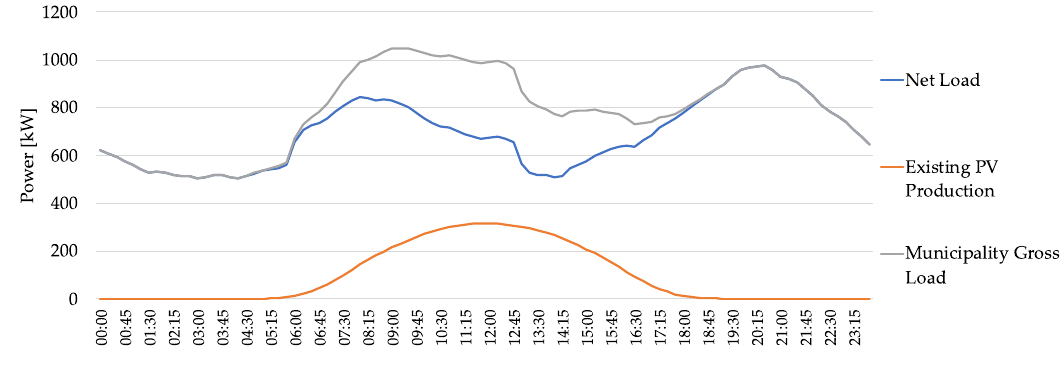
Figure 2. Current load profile and PV production in Berchidda urban network.